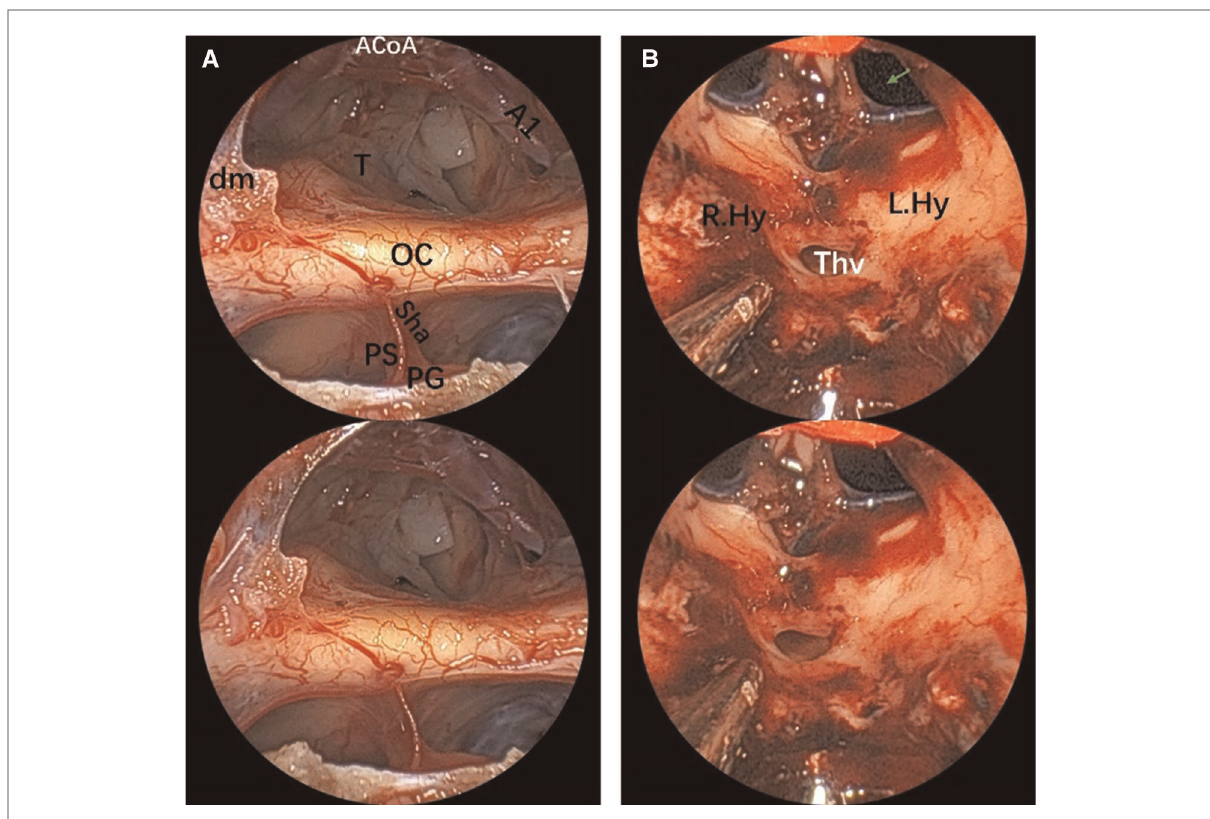
FIGURE 7 Endoscopic visualization of a suprasellar craniopharyngioma. ( A ) View of optic nerves, the chiasm and the anterior complex during extracapsular dissection of a large suprasellar craniopharyngioma. The tiny vessels adherent to the tumor are clearly demonstrated, which helps perform meticulous dissection maneuver. ( B ) Final view of the third ventricle after craniopharyngioma removal. The 3D image can be obtained with cross-viewing method. PS, pituitary stalk; PG, pituitary gland; OC, optic chiasm; sha, superior hypophyseal artery; T, tumor; dm, dura mater; ThV, third ventricle; green arrow, foramen of Monro; A1, segment of anterior cerebral artery; ACoA, anterior communicating artery, Hy,